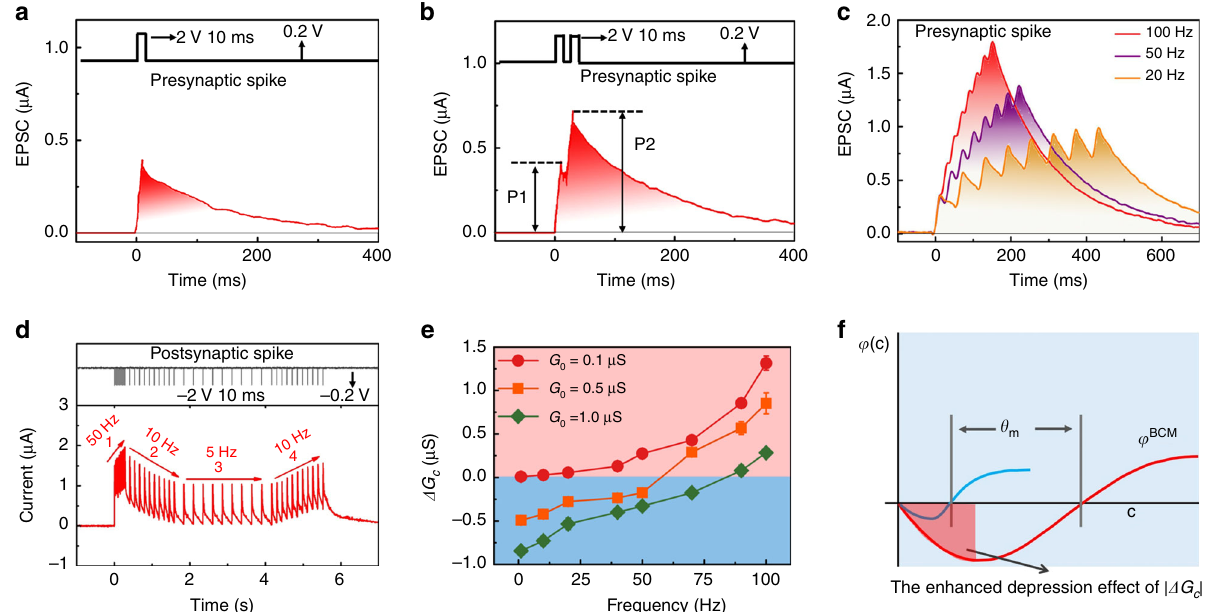
Fig. 2 Emulation of the rate-based synaptic adaptation function using postsynaptic spikes in the Pt/WO 3 − x /W memristors. a, b Synaptic EPSC and PPF functions triggered by a presynaptic spike [2 V, 10 ms] and paired spikes. c Dependence of the EPSC amplitude on the rate of presynaptic spike trains (20, 50, and 100 Hz). Eight pulses [2 V, 10 ms] were used to stimulate the device. d Response of the synaptic weight (conductance G c ) to a group of postsynaptic spike trains with a frequency sequence (50 Hz → 10 Hz → 5 Hz → 10 Hz). The pulse [ − 2V, 10 ms] on the bottom electrode as the postsynaptic spike. e Sliding threshold effect of the history-dependent synaptic adaptation function with different G 0 . Herein, the experienced G 0 was activated to three levels starting from a fi xed initial conductance of G i = 0.1 µ S. For the case of G 0 = 0.5 µ S and 1.0 µ S, the stimulation was conducted